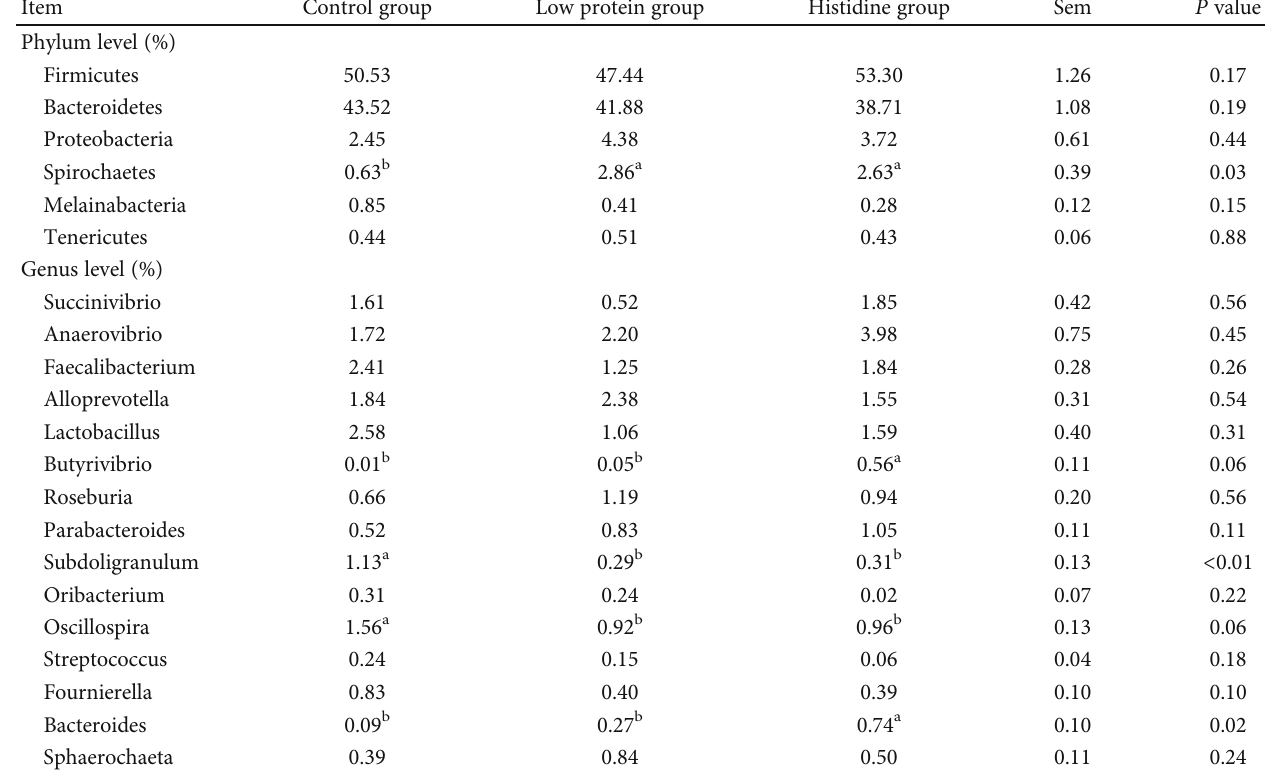
Table 7: E ff ect of dietary histidine on gut microbiota compositions in low protein diet-fed